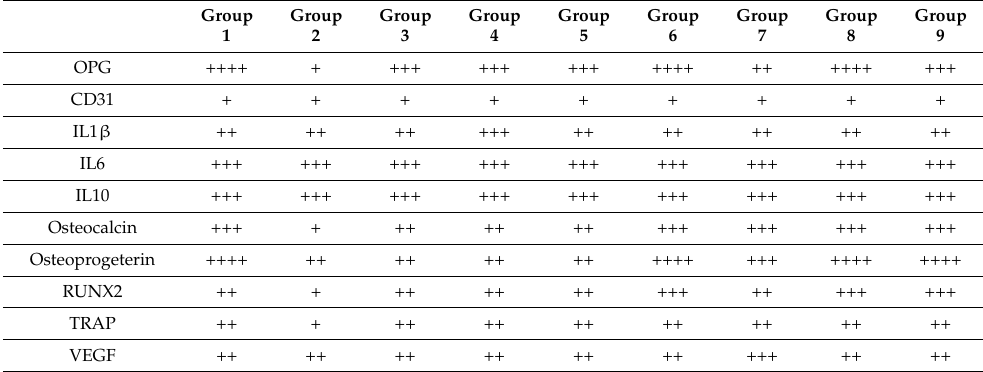
Table 2. Immunohistochemistry reaction intensity for all investigated factors in all experimental groups. Group Group 1